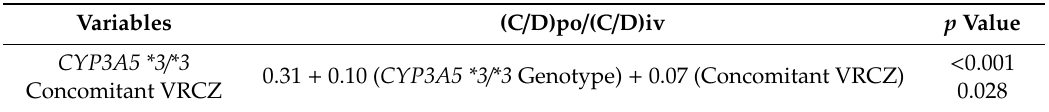
Table 6. Multiple logistic regression analysis of variables associated with an increase in tacrolimus (C / Dpo) / (C / Div) ( n =